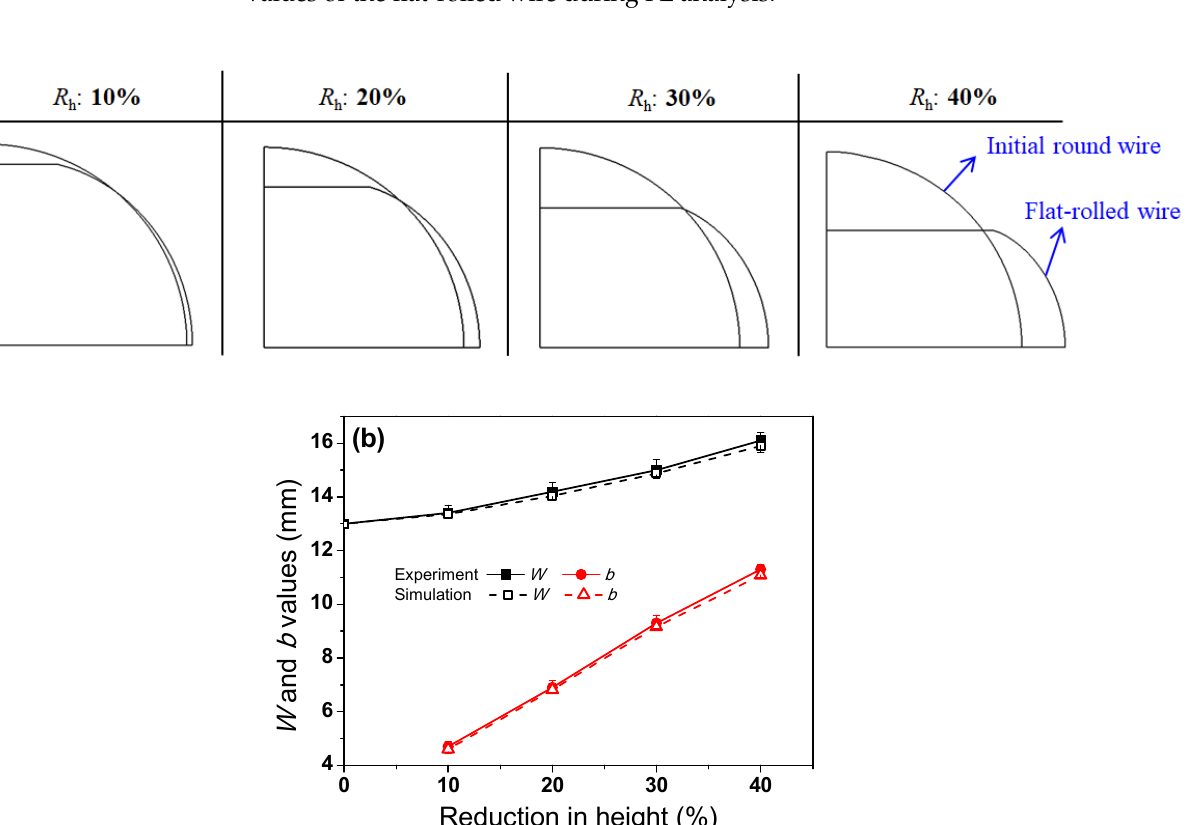
Figure 4. ( a ) Comparison of shape variation in flat-rolled wire with R h based on FE analysis and ( b ) comparison of W and b values obtained from experiment and FE analysis with R h at a roll diameter of 400 mm.